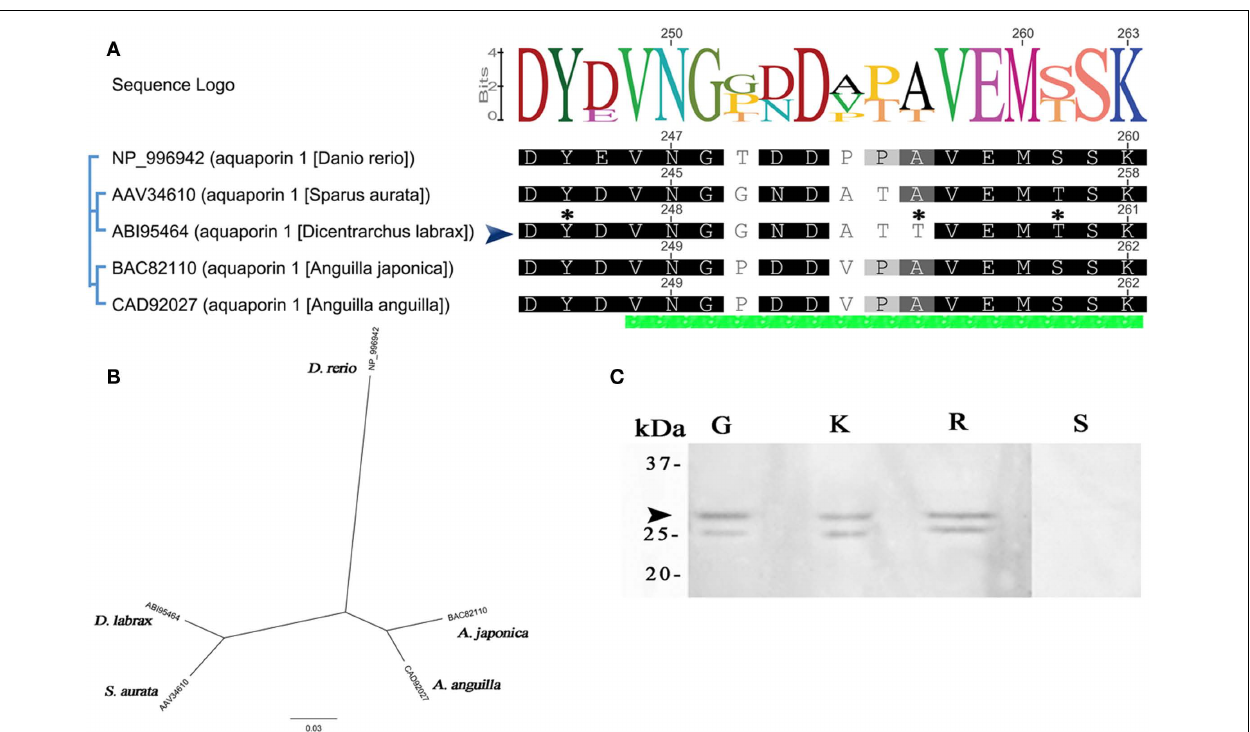
numbering. Potential phosphorylation sites for sea-bass are indicated with an asterisk. (B) Phylogenetic relationships among aligned AQP1a aquaporins.The unrooted phylogenetic tree was constructed using the NJ method.The bar indicates the mean distance of 0.03 changes per amino acid residue. (C) RepresentativeWestern blot of protein extracts (30 μ g) from gills (G), kidney (K), and rectum (R). Negative control without the primary antibody (S).The apparent molecular masses (kDa) are indicated on the left.The arrow indicates the ∼ 28kDa sea-bass AQP1a